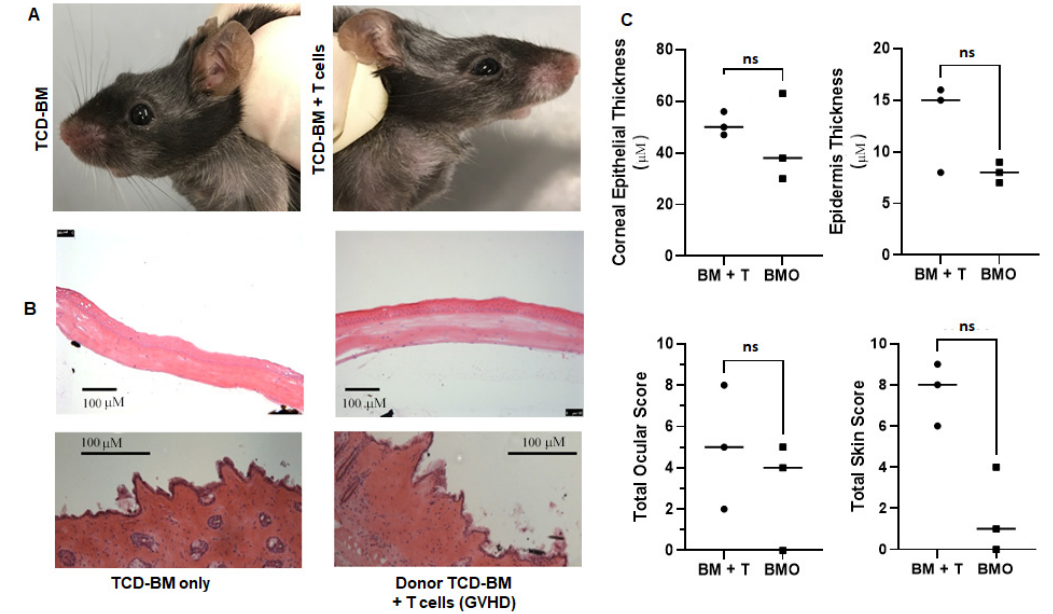
Figure 4. Development of ocular and skin GVHD following HSCT in an MHC-mismatched donor/recipient strain combination. Transplants were performed using donor B6 (H2b) bone marrow +/ − spleen cells containing T cells into B10.BR (H2k) recipients. ( A ) Clinical examination of animals approximately 8-weeks post-HSCT revealed marginal clinical with virtually no edema and eyelid swelling in the ocular compartment in mice receiving BM only or BM + T cells. Only mice with both ocular and skin histologic samples were included. This led to n = 4/group in both BM + T cells and BMO groups. ( B ) The histological examination of the cornea did not identify epithelial thickening in the cornea or skin or corneal stromal thinning. Data presented represent individual B10.BR animals at Day 56. ( C ) The analysis of representative mice found the total histological ocular and skin scores were not significantly different between recipients of BM only vs. BM + T cells. ns denotes p values that were >0.05.